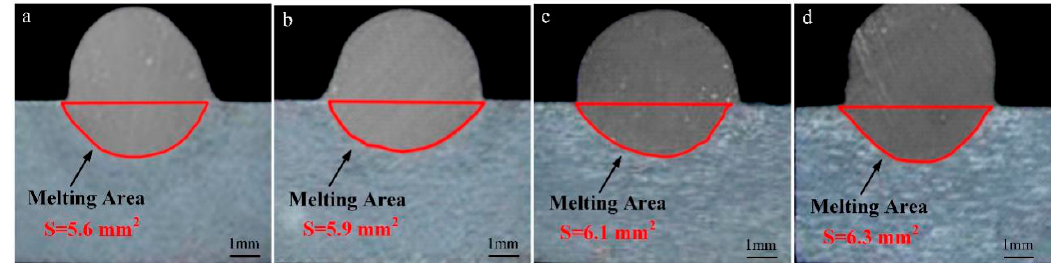
Figure 16. Weld shape and melting area of the base metal when I MIG-EN is varied and I VPPA-EN = 50 A for I MIG-EN of ( a ) 70 A, ( b ) 80 A, ( c ) 90 A, and ( d ) 100 A.